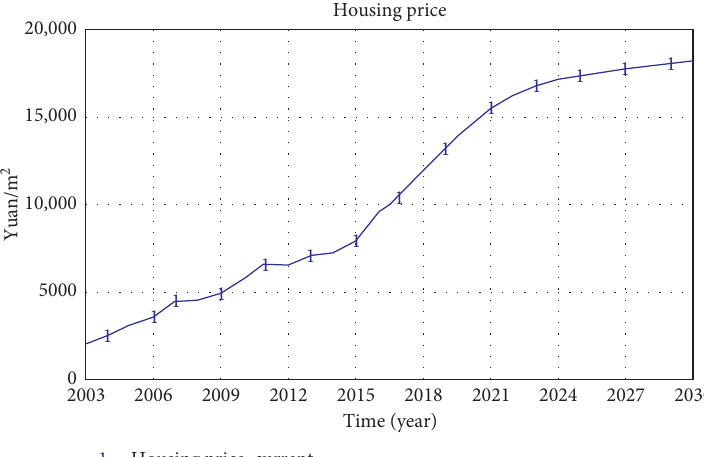
Figure 12: Forecast value of commodity housing price. (reproduced from J. Y. Guo and J. W. Wang’s article[21]: “Housing price research based on system dynamics model,” IOP Conference Series: Earth and Environmental Science, ISTTCA, 2020).